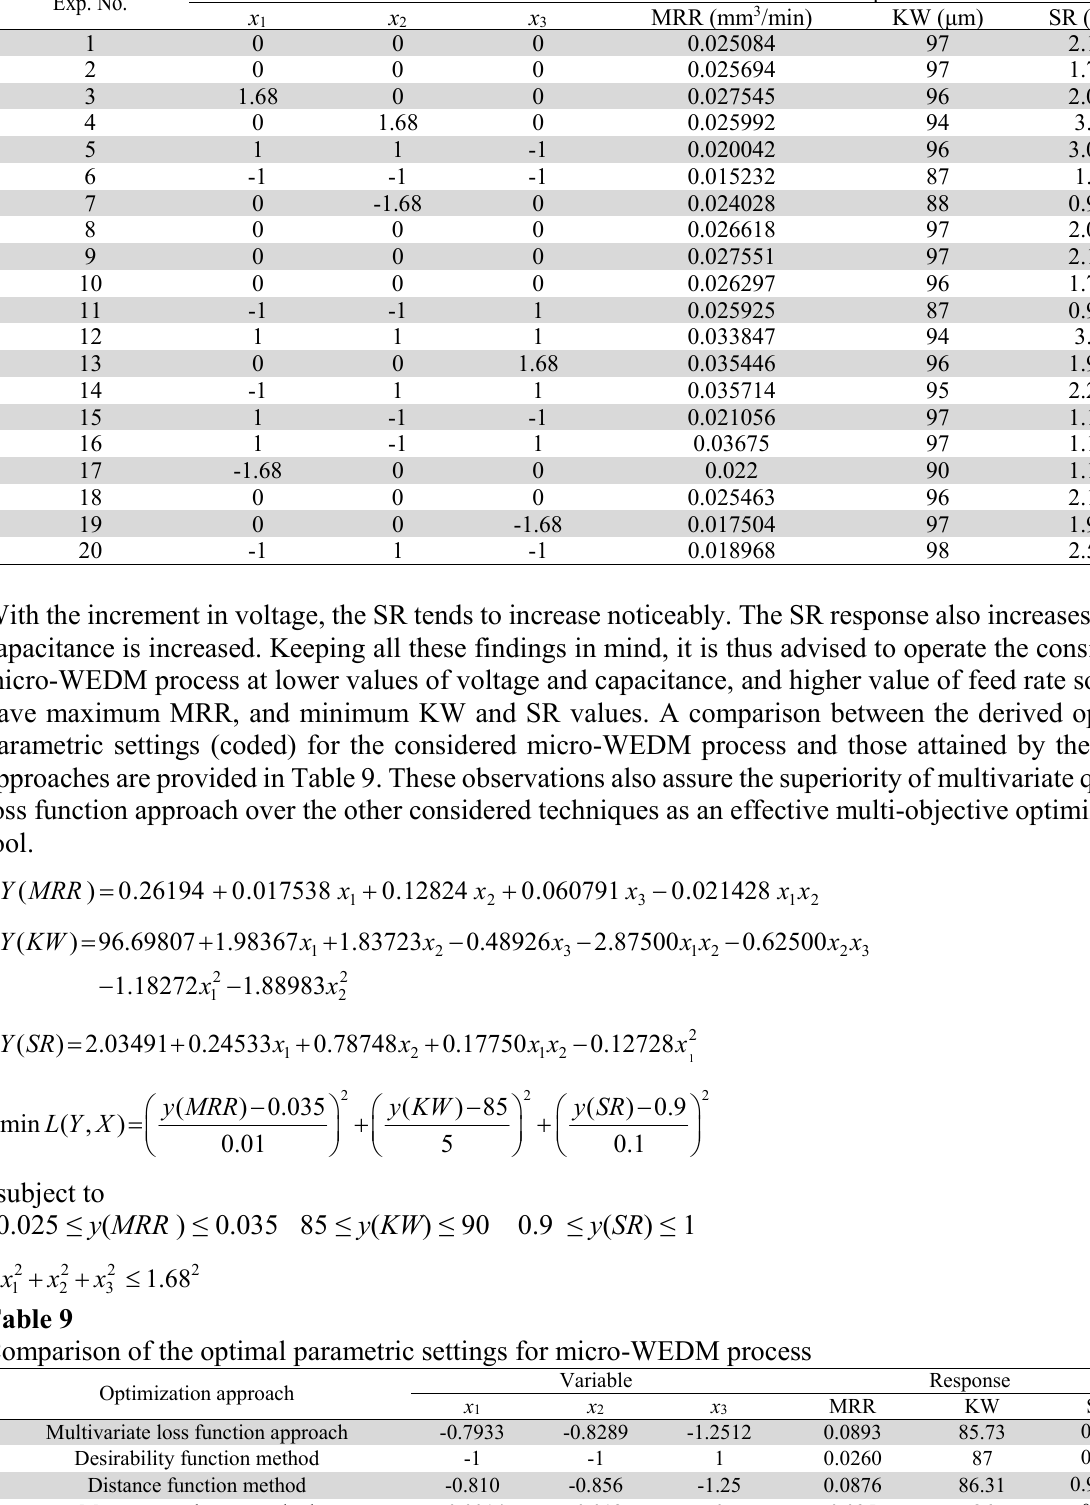
Experimental data for micro-WEDM process (Sivaprakasam et al., 2013) Exp. No.